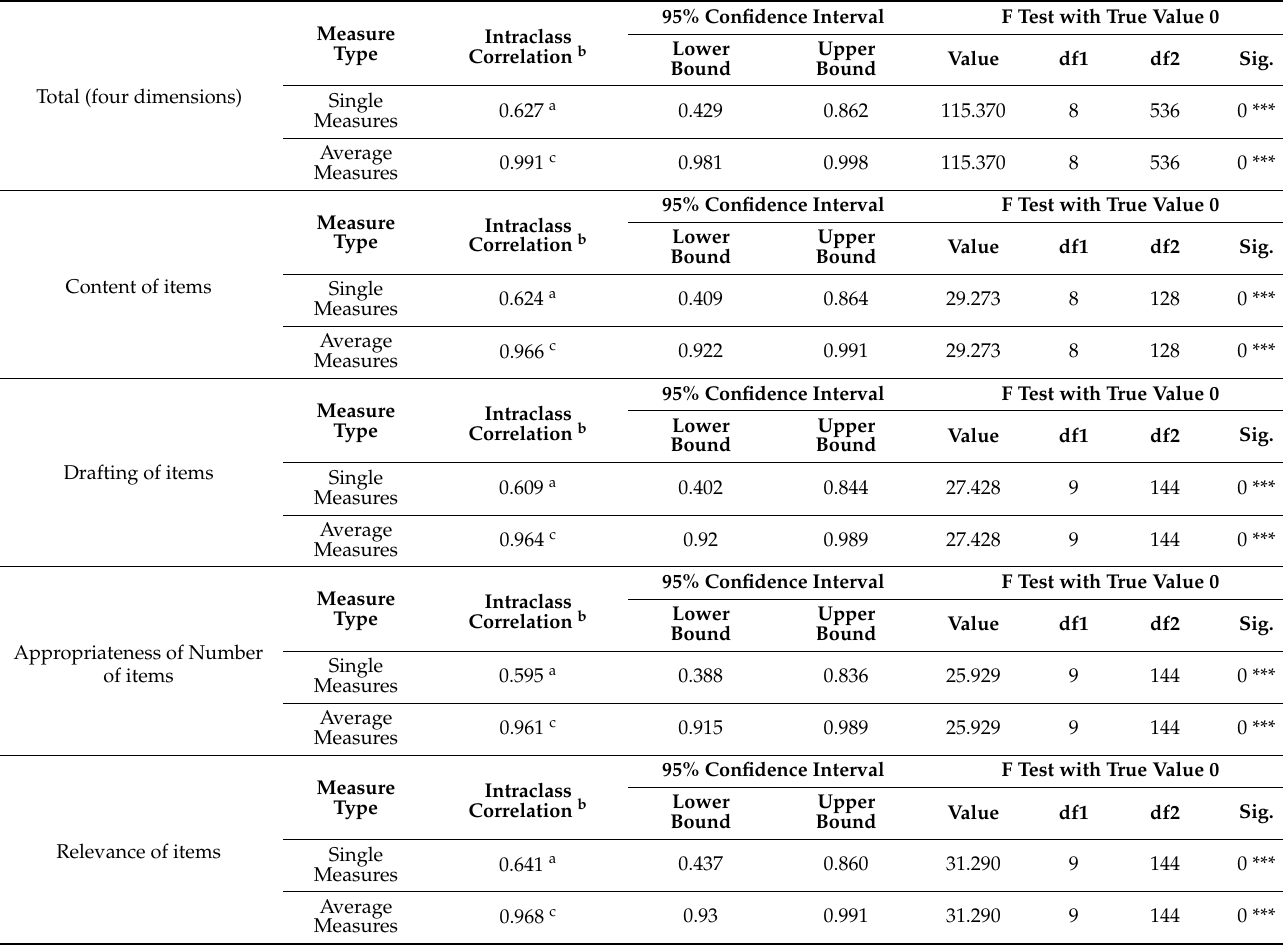
Table 6. Results of the absolute agreement between experts calculated using the intraclass correlation